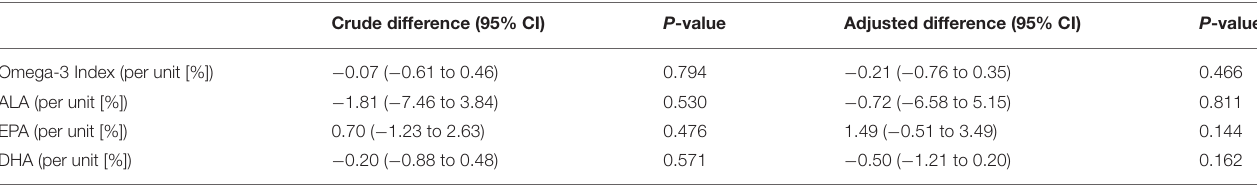
TABLE 3 | Crude and adjusted difference in eGFR for Omega-3 Index, ALA, EPA, and